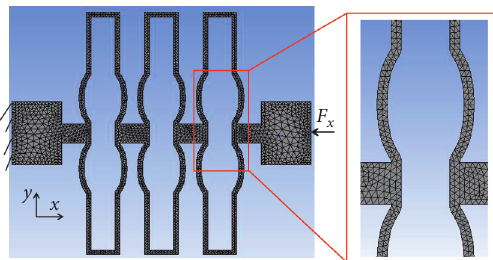
Figure 5: The meshed model of the TLET